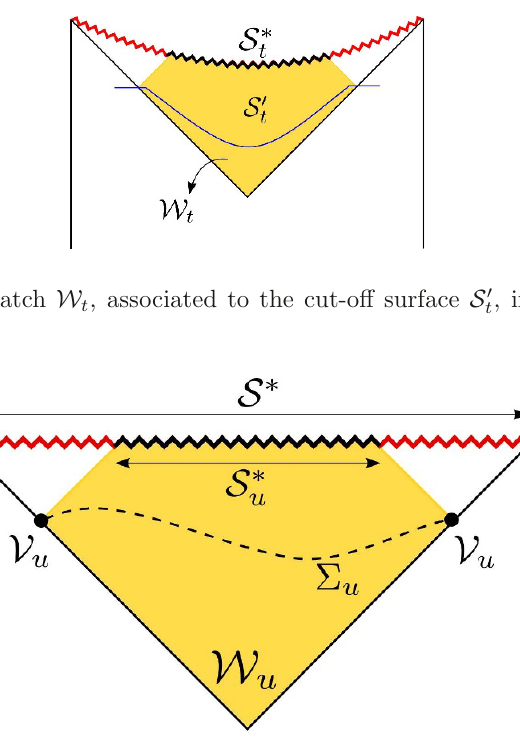
Figure 5 . The WdW patch W u (in yellow), associated to a given S ∗ u subset (in black) of the full terminal set S ∗ (in red). The codimension-two set V u is the (possibly disconnected) boundary of Cauchy surfaces Σ u for W u